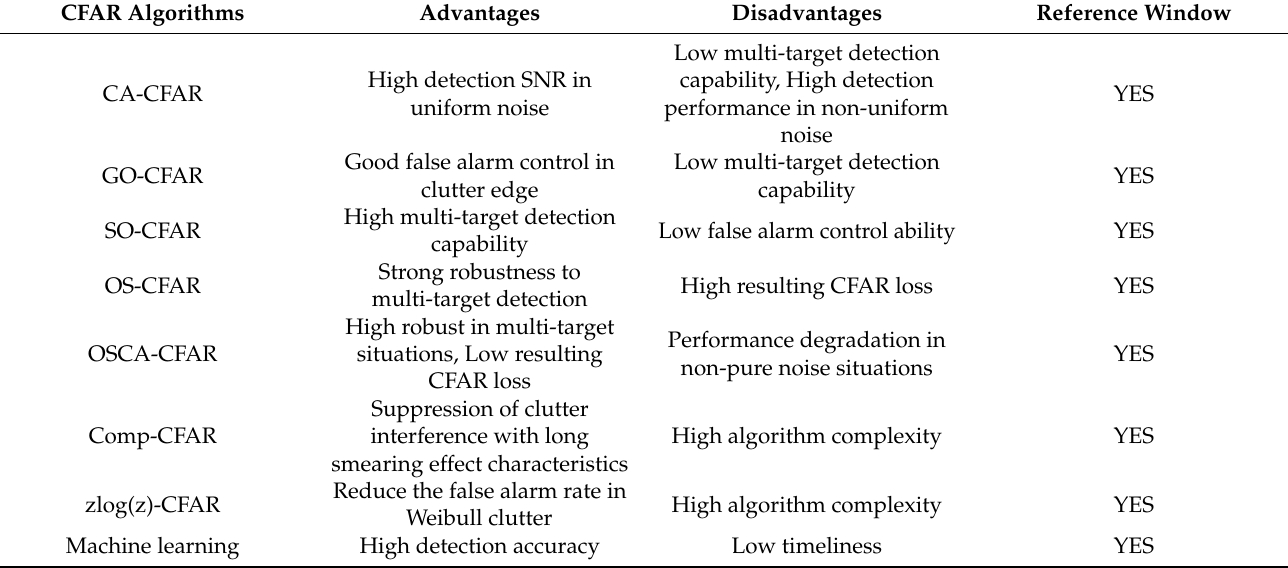
Table 1. A brief summary of the characteristics of CFAR algorithms. CFAR Algorithms Advantages Disadvantages Reference